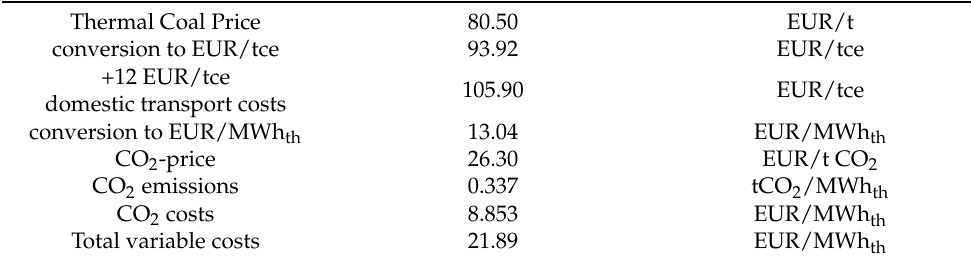
Table 5. Calculation of variable costs from the scenario fuel assumptions (shown for baseline